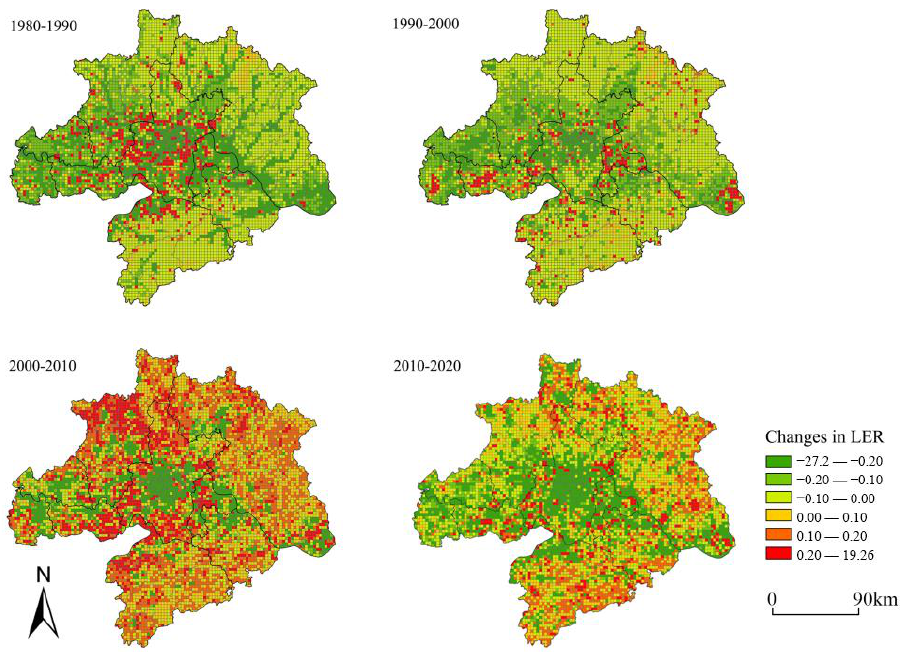
Figure 4. Change in landscape ecological risk from 1980 to 2020. Table 3. Ecological risk index of WUA, 1980 – 2020.